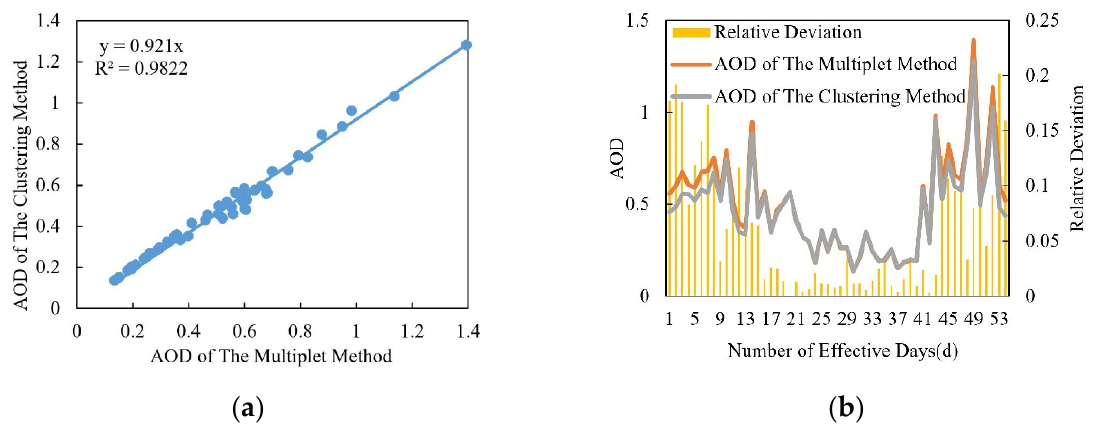
Figure 2. Comparative analysis of retrieval results of the multiplet method and the clustering method. ( a ) Fitting of retrieval results. ( b ) Trend and relative deviation of retrieval results.